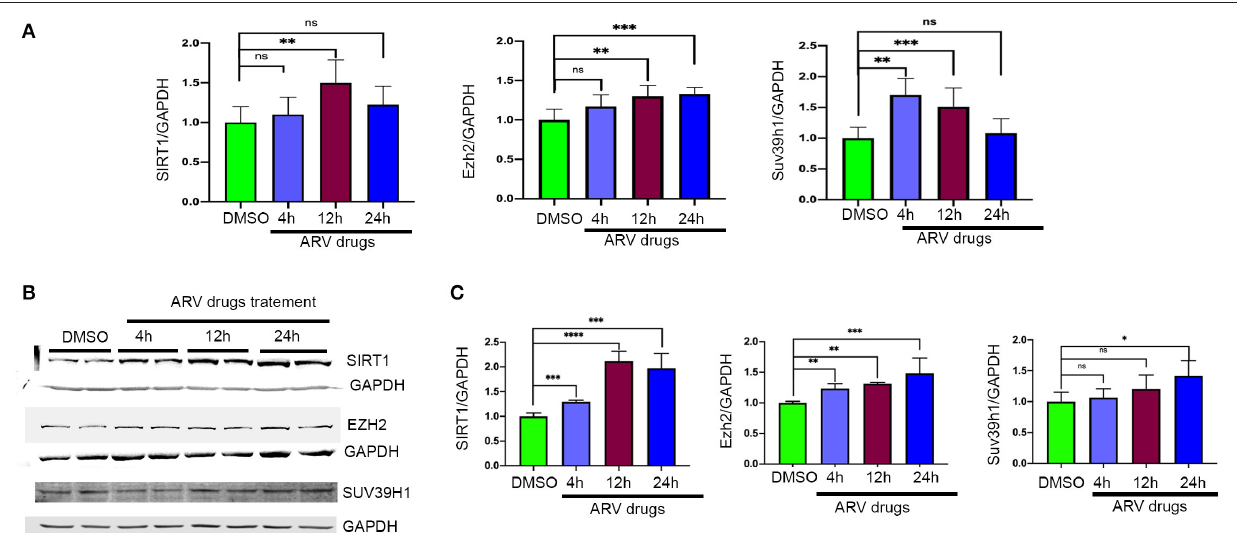
FIGURE 4 | Expression of epigenetic chromatin enzymes affected by ARV drugs treatment. (A) Graphs showing mRNA expression of Sirt1, Ezh2, and Suv39h1 in NRVCs treated with drugs. Cells were treated with ARV drugs (5 µ M of Ritonavir, Abacavir, Atazanavir and Lamivudine) for different time point (4, 12, and 24h) and expression was checked by qRT-PCR. (B,C) Western blots showing protein expression of SIRT1, SUV39H1, and EZH2 enzymes and graph show quantification. NRVCs were treated with ARV drugs (5 µ M of Ritonavir, Abacavir, Atazanavir, and Lamivudine) for 4, 12, and 24h and expression was checked in total protein lysate by western blot with respective antibody (* p < 0.05, ** p < 0.01, *** p < 0.001, **** p < 0.0001, ns, not significant).